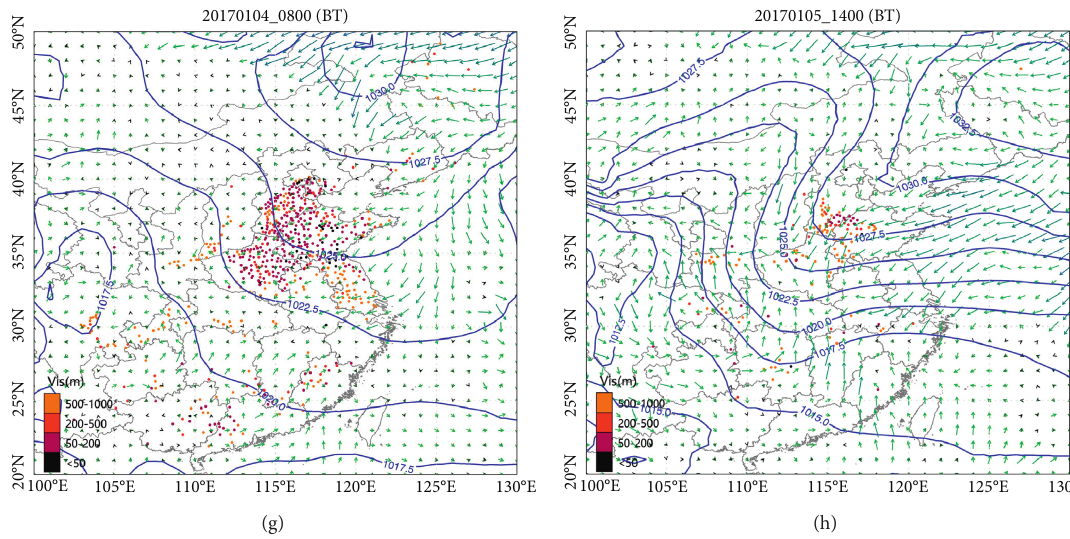
Figure 5: Synoptic system and wind field on the ground from December 30, 2016, to January 5, 2017. (a) 20161231_0800 (BT). (b) 20170101_2000 (BT). (c) 20170102_0800 (BT). (d) 20170102_2000 (BT). (e) 20170103_0800 (BT). (f) 20170104_0200 (BT). (g)